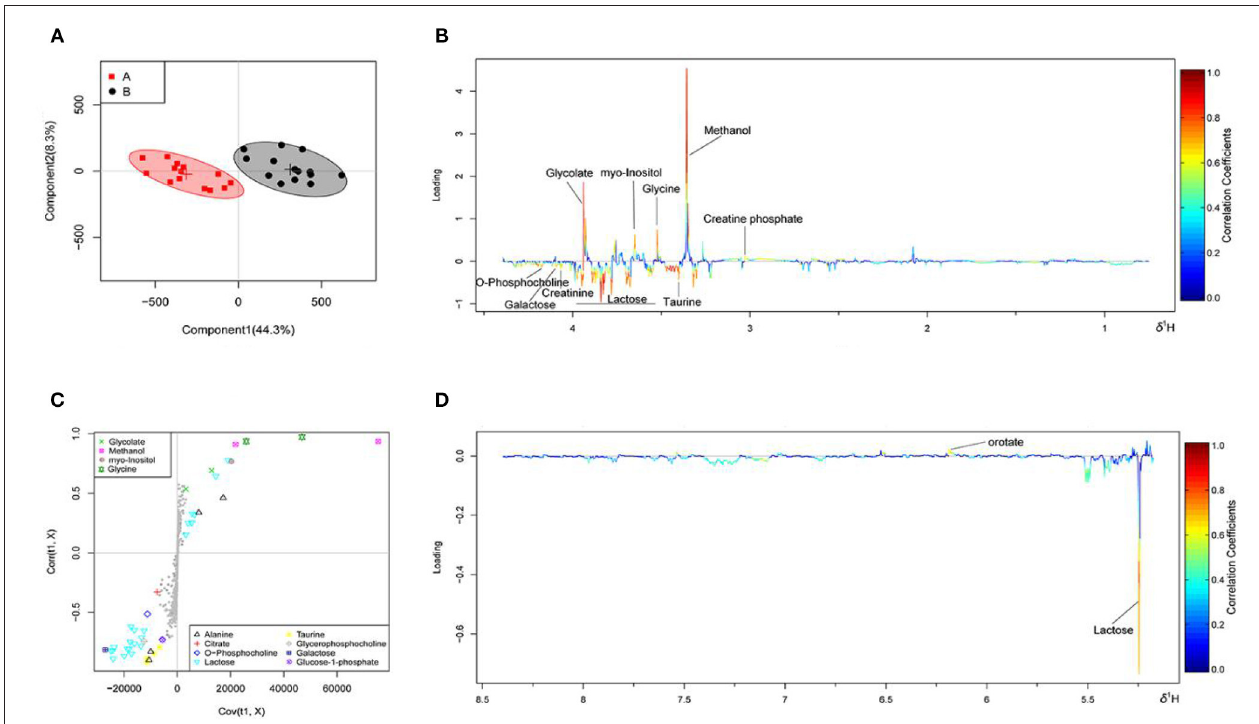
FIGURE 2 | Orthogonal signal correction partial least squares discriminant analysis (OSC-PLS-DA) of milk whey 1 H-NMR data from groups A and B. (A) Score plot in which one point represents one sample and one ellipse represents a confidence interval of 95%. A: estrus group ( ); B: inactive ovaries group (•). (B,D) Corresponding loadings plot (0.5–4.4 ppm, 5.175–8.5 ppm) where the significance is from highest in red to lowest in blue. Metabolites above the baseline are more abundant in group B, while under the baseline are more abundant in group A. (C) S-plot in which different metabolites are distinguished by different colors and shapes. The different metabolites are in the upper right or lower left, and the metabolite is more significantly different if it is farther away from the